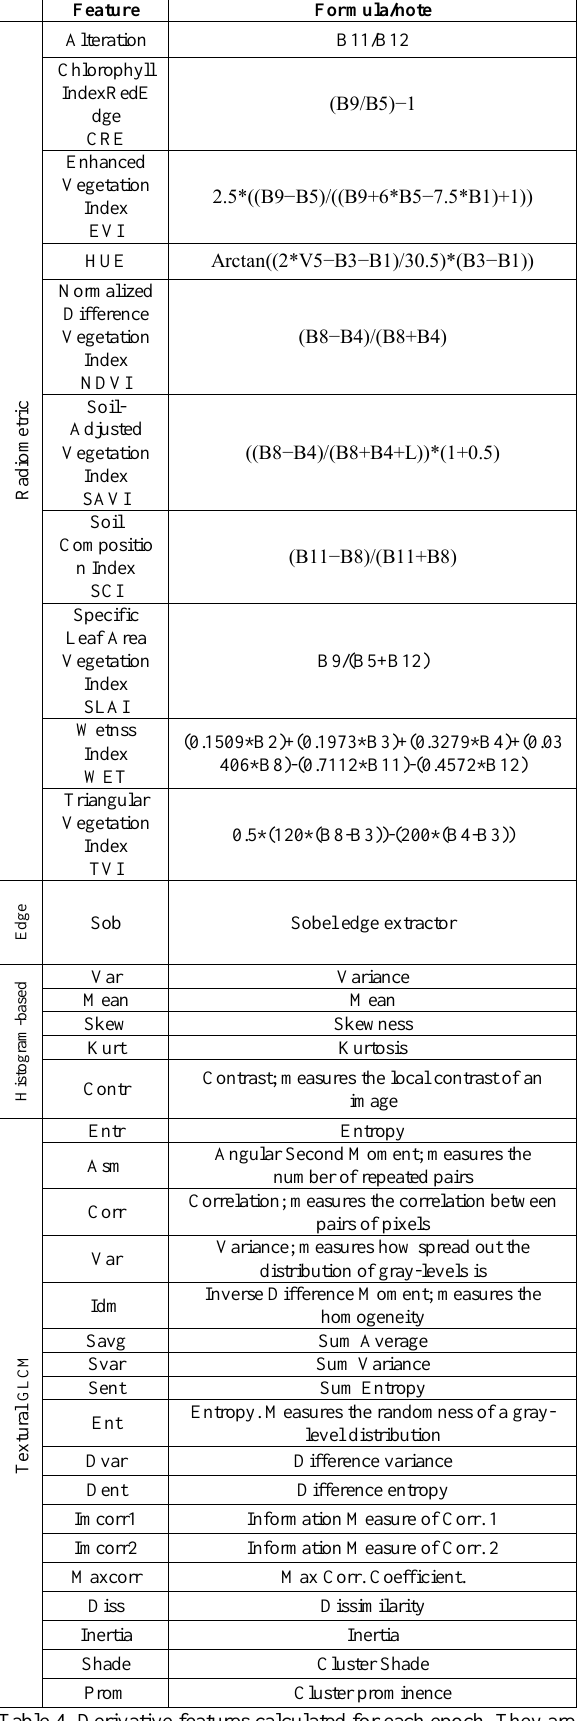
Table 4. Derivative features calculated for each epoch. They are divided into 4 groups: histogram-based, radiometric, edge extractor and